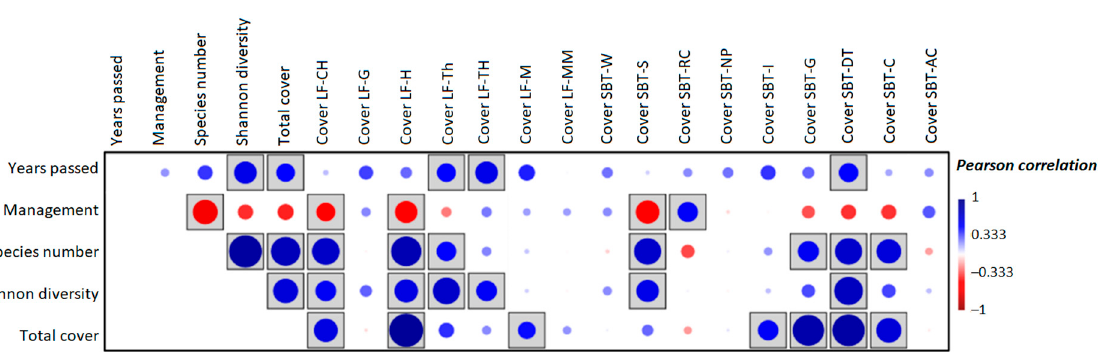
Figure 5. Linear (Pearson) correlation of years passed, management, species number, Shannon diversity, and total cover with cover of different life forms (LF) and social behavior types (SBT) (blue: positive, red: negative correlation, boxed: p < 0.05 significance). Ch: chamaephytes; G: generalists;